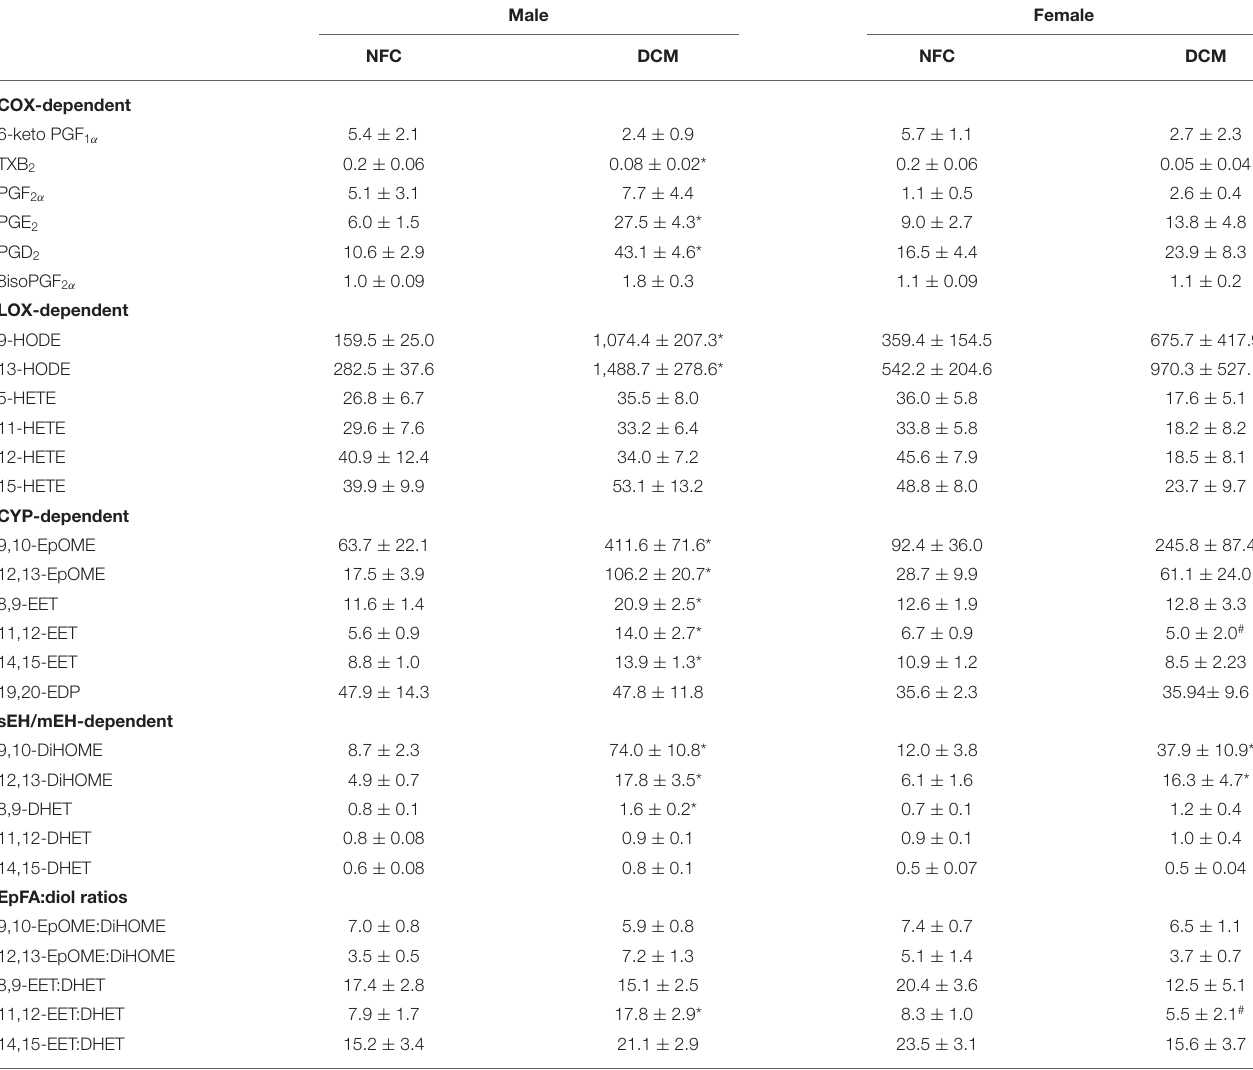
TABLE 2 | N − 3 and N − 6 oxylipin profile (ng/g tissue) from LV heart biopsies measured by LC-MS/MS.